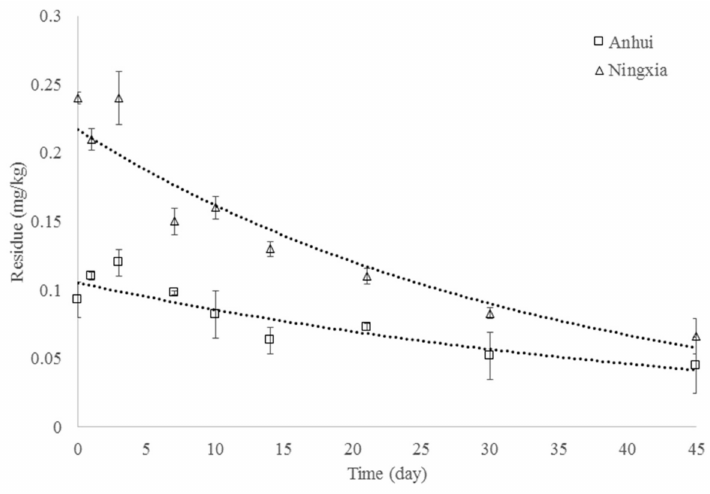
Figure 3. Dissipation curves ( n = 3) of benziothiazolinone in apple in Anhui and